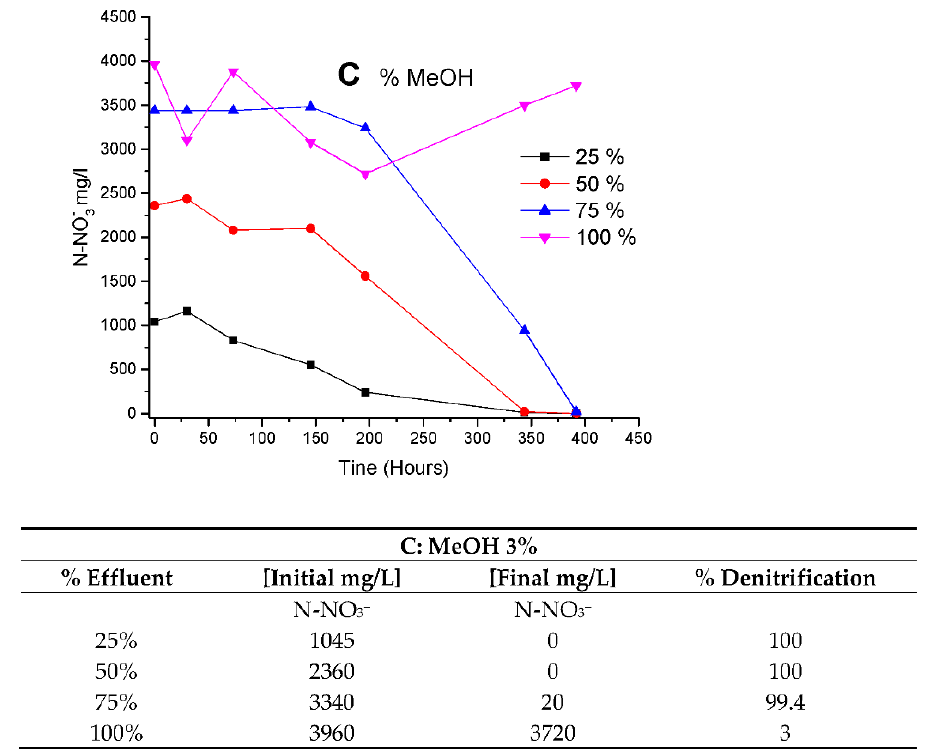
Figure 7. Performance of denitrification ( A ) without methanol and up to 75% of effluent, ( B ) 1% of methanol up to 100% of effluent and ( C ) 3% of methanol up to 100% of effluent.